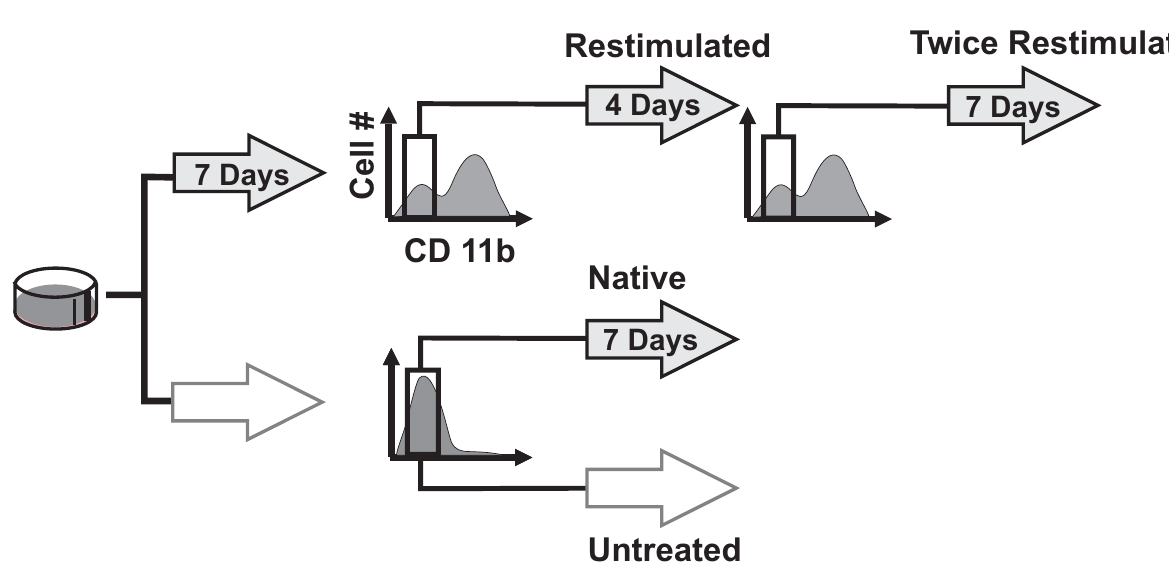
Figure 6 Experimental design for analyzing multi-dimensional dynamics of differentiation . Shaded block arrows represent cells exposed to 0.8% DMSO for the indicated durations while open arrows indicate "untreated" cell cultures. Brackets indicate subpopulations sorted with FACS. The fraction of CD11b High cells was monitored by flow cytometry daily for 7 days for the "restimulated", "native" (mock-sorted and restimulated) and "untreated" groups. A CD11b Low fraction that was re-established upon restimulation with 0.8% DMSO for 4 days was also sorted, restimulated a second time ("twice restimulated"), and moni- tored by flow cytometry for 6